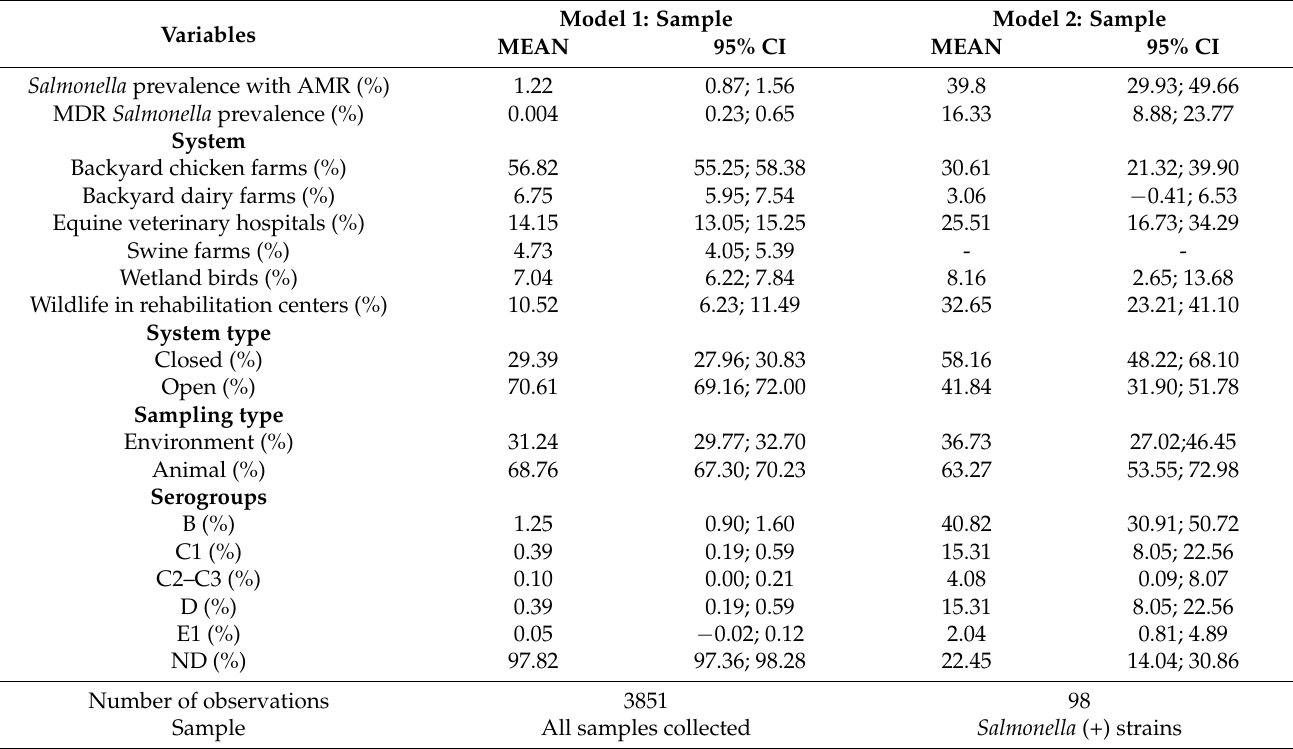
Table 2. Descriptive statistics by sample